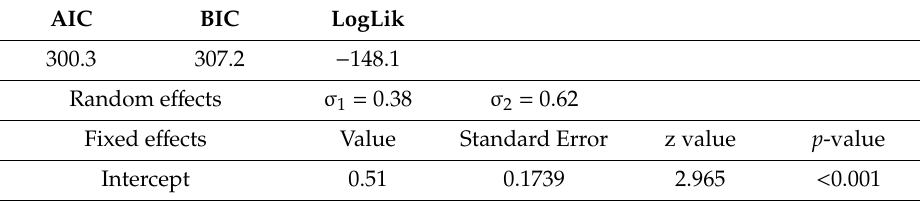
Table 1. Parametric estimation results for the simplest two level model Equation (1). AIC BIC LogLik 300.3 307.2 − 148.1 Random e ff ects σ 1 = 0.38 σ 2 = 0.62 Fixed e ff ects Value Standard Error z value p -value Intercept 0.51 0.1739 2.965 < 0.001